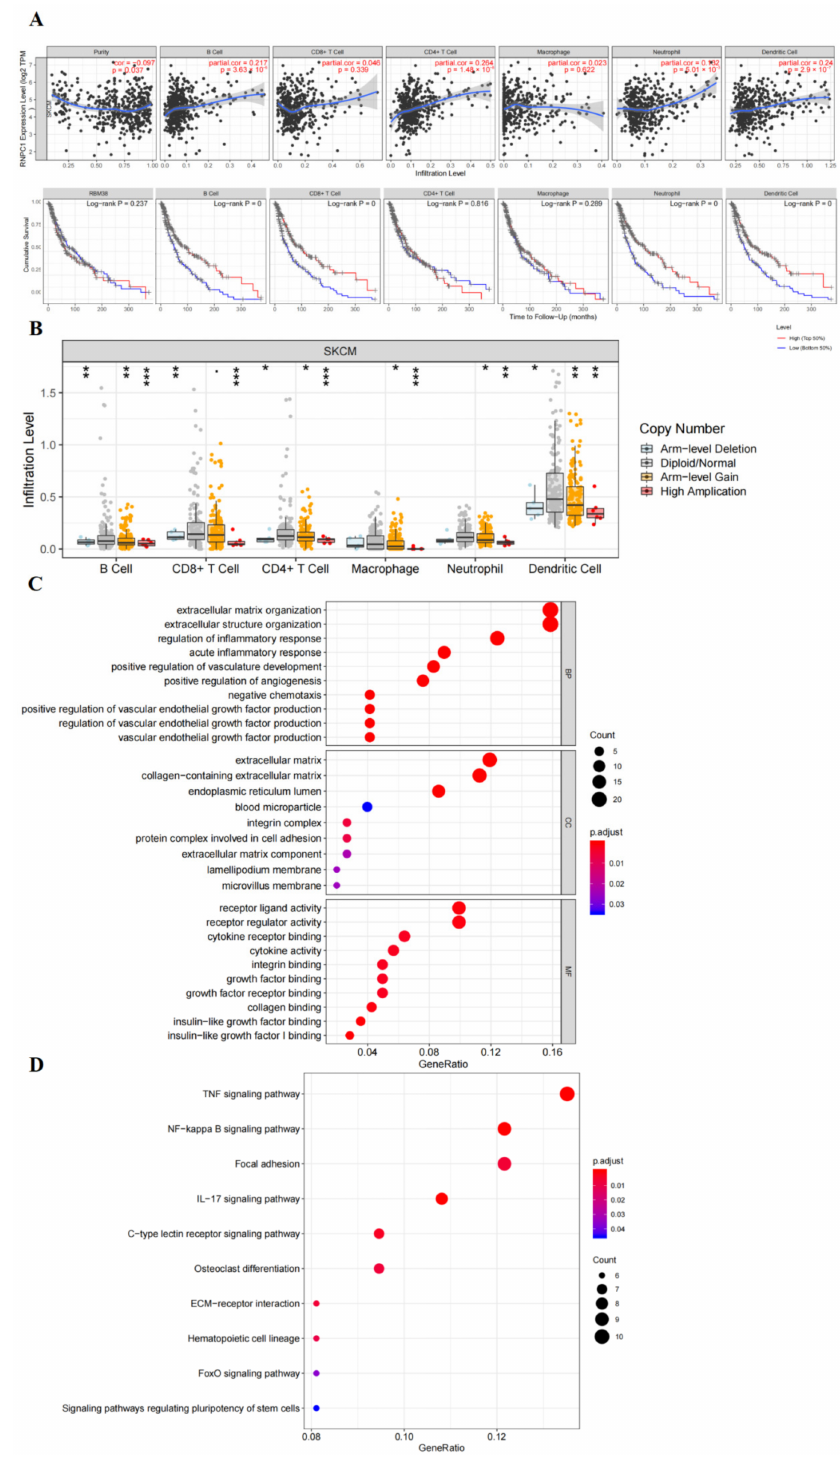
Figure 4. RBM38 correlated with the immune system and GO and KEGG pathway analysis. ( A ) The correlation between RBM38 expression and the level of immune cell infiltration and in the database of TIMER. ( B ) The correlation between RBM38 copy number variation (CNV) and the level of immune cell infiltration in the TIMER database. (* p < 0.05, ** p < 0.01, *** p < 0.001). ( C ) Bubble plots of GO analysis of the biological process of the differentially expressed genes related to RBM38. ( D ) Bubble plots of KEGG analysis of the biological process of the differentially expressed genes related to